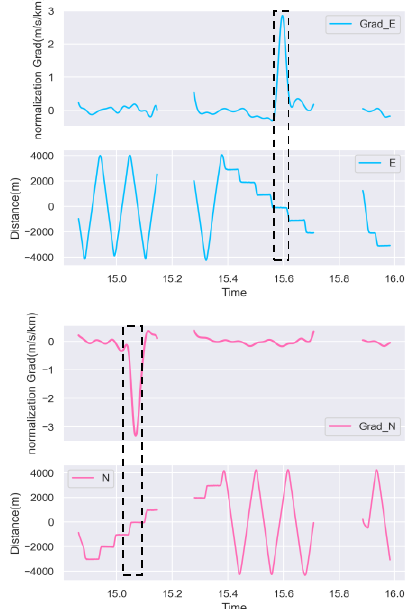
Figure 11 . Horizontal distance from the transducer to the transponder and spatial gradient.